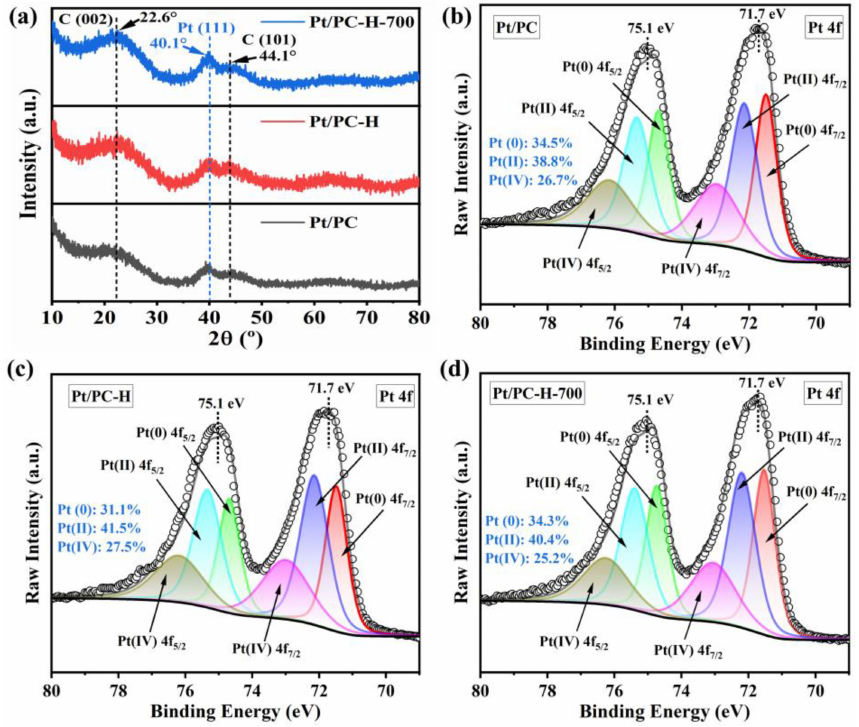
Figure 5. XRD patterns ( a ) and high-resolution Pt 4f spectra of Pt/PC ( b ), Pt/PC-H ( c ), and Pt/PC-H- 700 ( d ) catalysts.